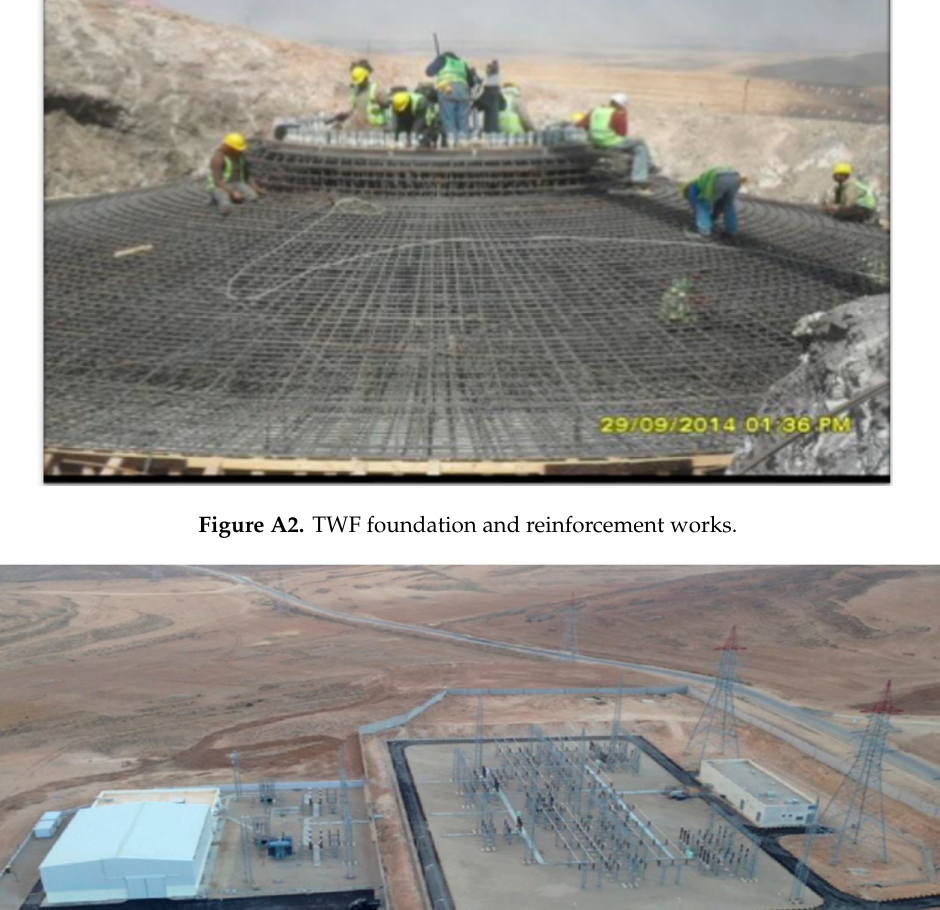
Figure A1. Image of the location of the Tafilah Wind Farm (TWF).